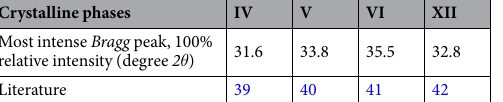
Table 1. Most intensive peaks (100% relative intensity) of the respective crystalline ice phases. Structural data were taken from literature 39–42